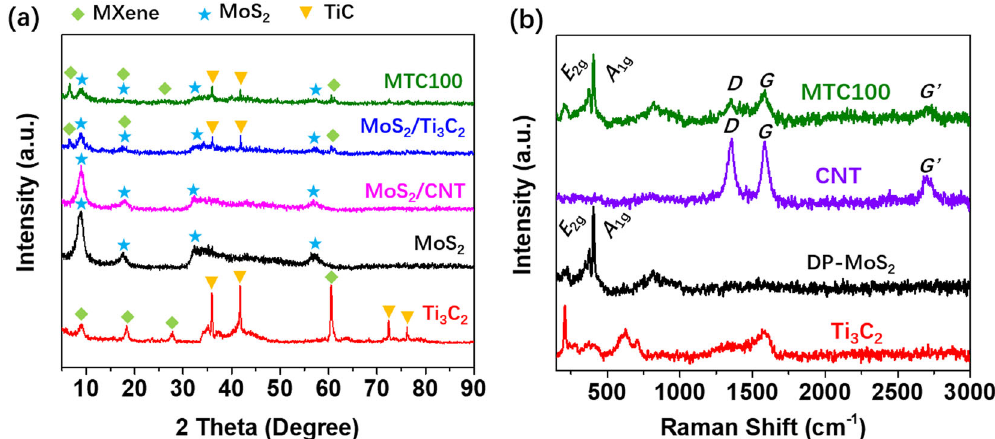
Fig. 3 The structure characterization of the MTC composite. The XRD patterns ( a ) and the Raman spectra ( b ) of various as-synthesized